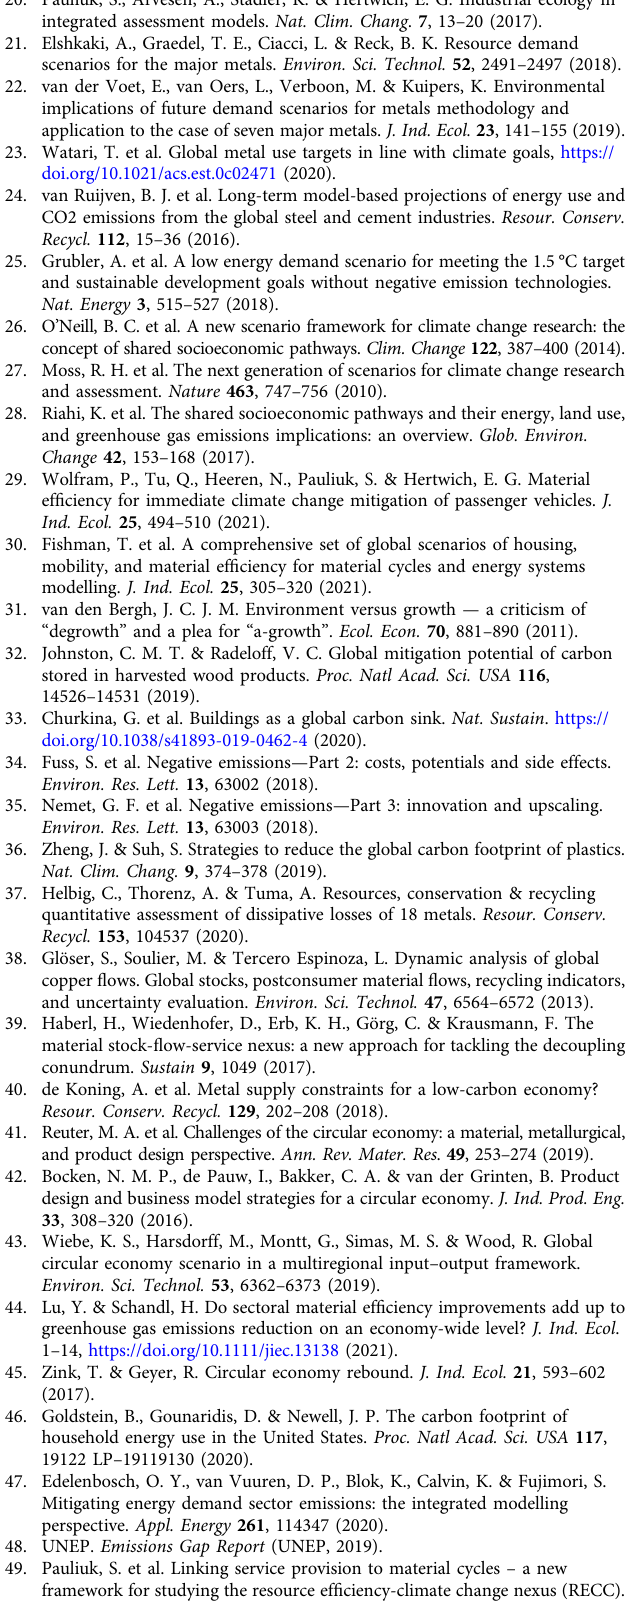
Overview table with main assumptions . Table 2 shows the main quantitative assumptions behind the RECC parameter datasets. For a complete overview, we refer to the RECC scenario publication 30 and database (https://doi.org/10.5281/ zenodo.4671643). The RECC system variables and model equations are listed and explained in Section 6 of the Supplementary Material. Data availability The input data and model results of this study were deposited on Zenodo with hyperlinks https://doi.org/10.5281/zenodo.4671643 for the input data and